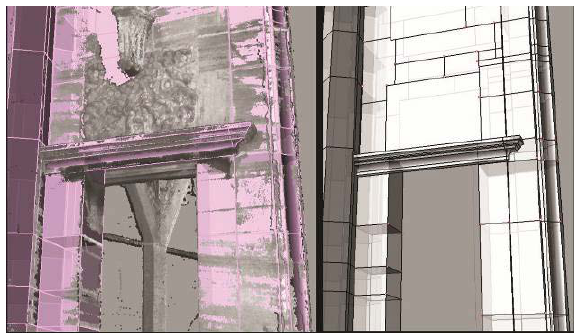
Figure 11: Example of a complete model of this part with subdivision into its constructive blocks. On the left, the comparison with the point cloud, on the right with check points collected